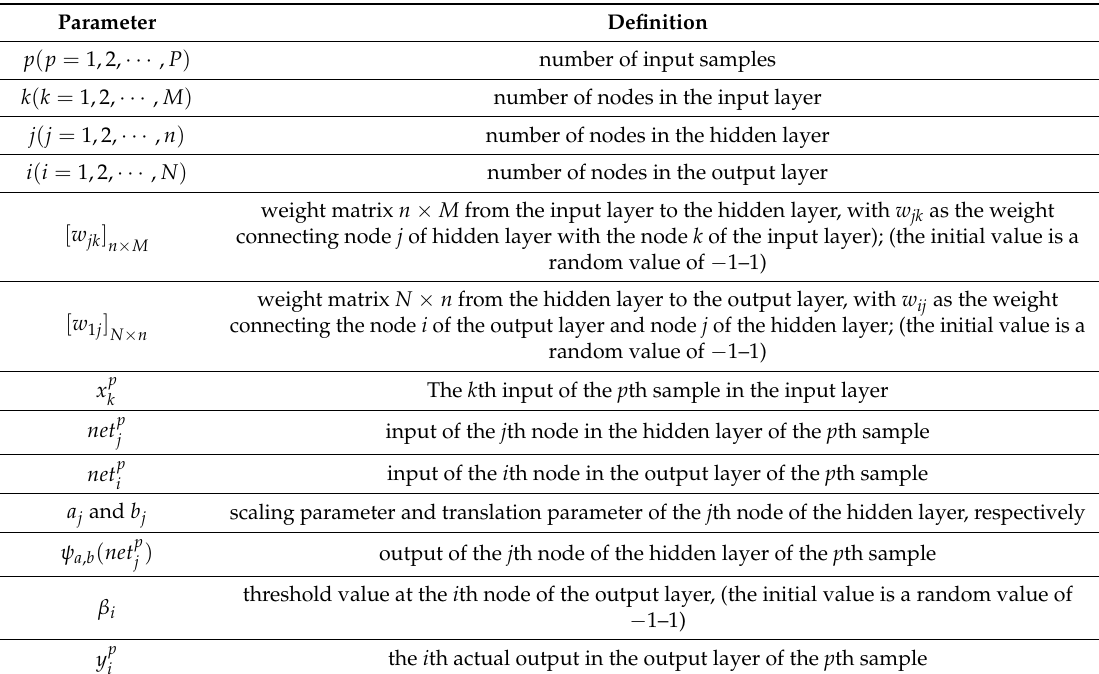
Table 5. The definition of parameters used in Equations